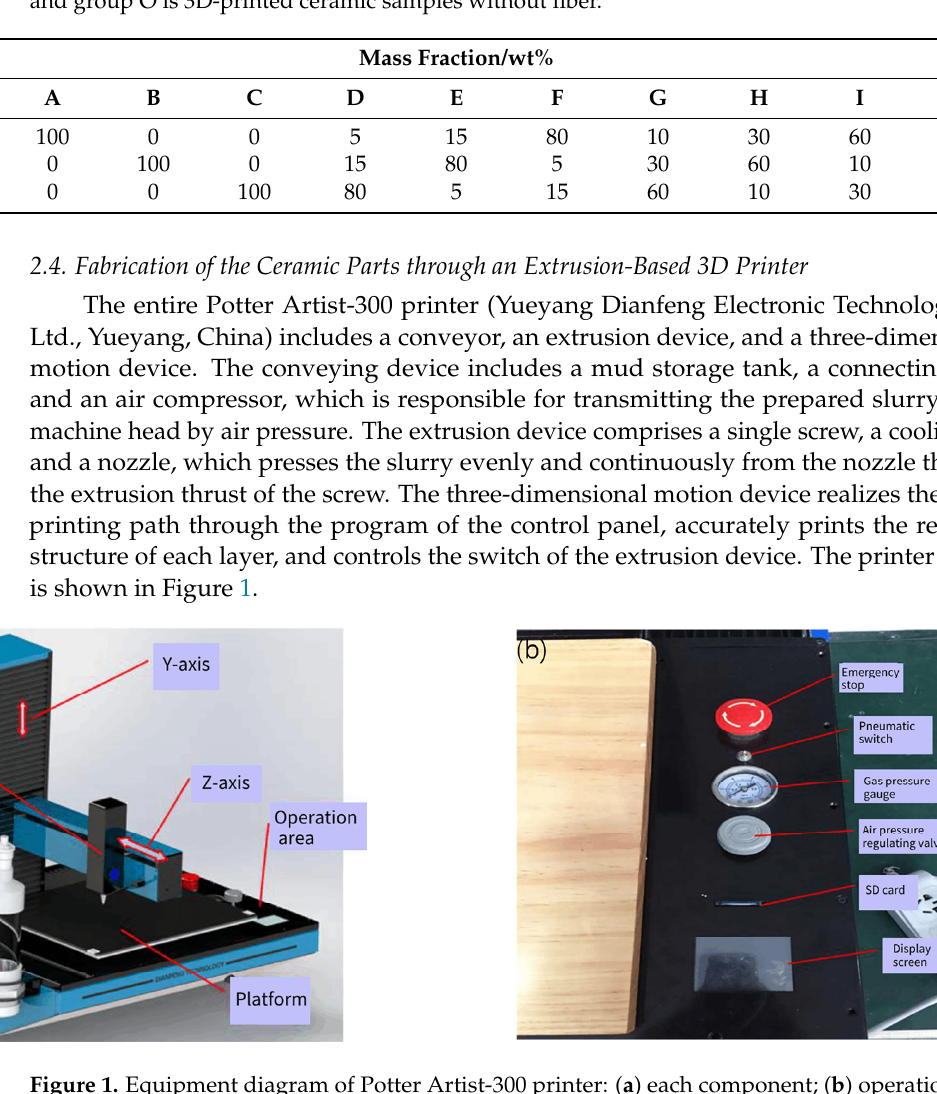
Table 1. Short carbon fibers of different lengths were mixed. The proportion of total fiber was 5 wt%, and group O is 3D-printed ceramic samples without fiber.